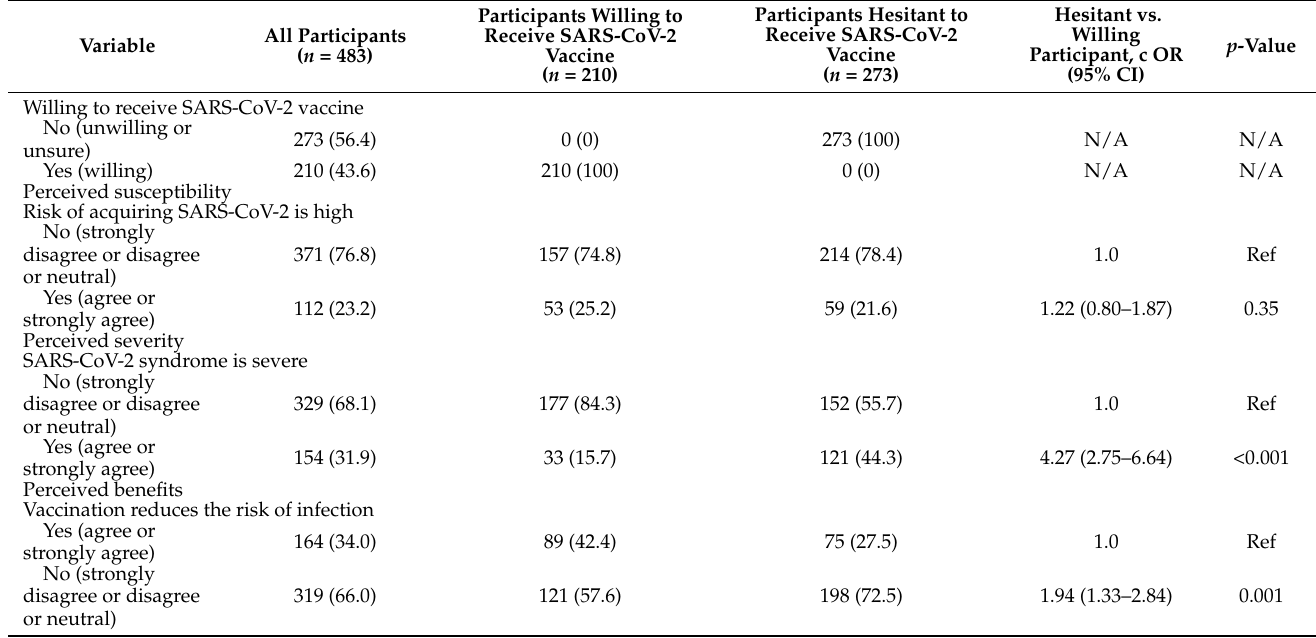
Table 3. Willingness to receive the SARS-CoV-2 vaccine among study participants and variables included in the health belief